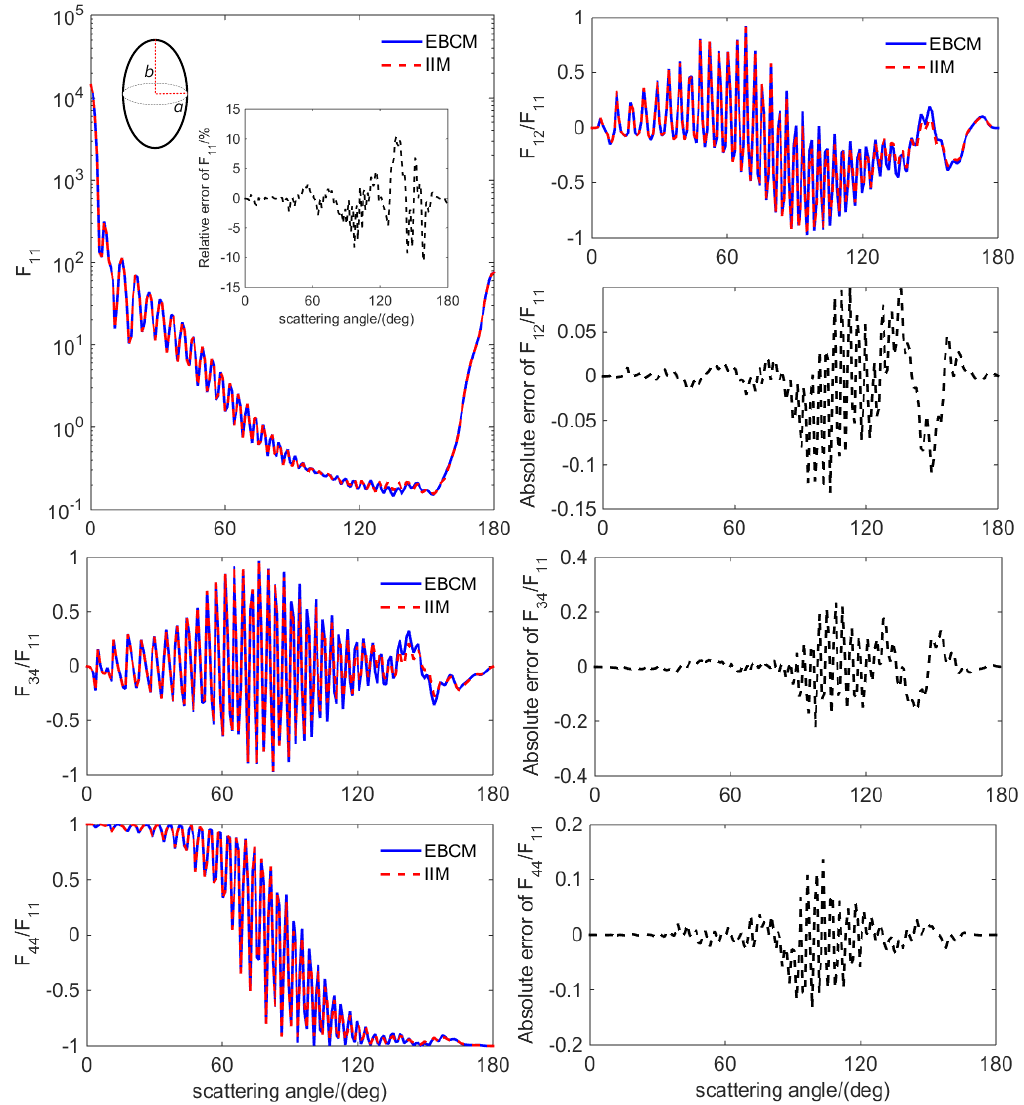
Figure 5. The scattering phase matrix obtained by the IIM and EBCM T-Matrix methods for the large spheroid particle. The simulation errors of F 11 are denoted by relative errors. For F 12 , F 34 , and F 44 , they are firstly normalized by F 11 , and their simulation errors are evaluated by the absolute errors. Table 2. The integral scattering parameters calculated by the IIM and EBCM T-Matrix methods for the large spheroidal particle.